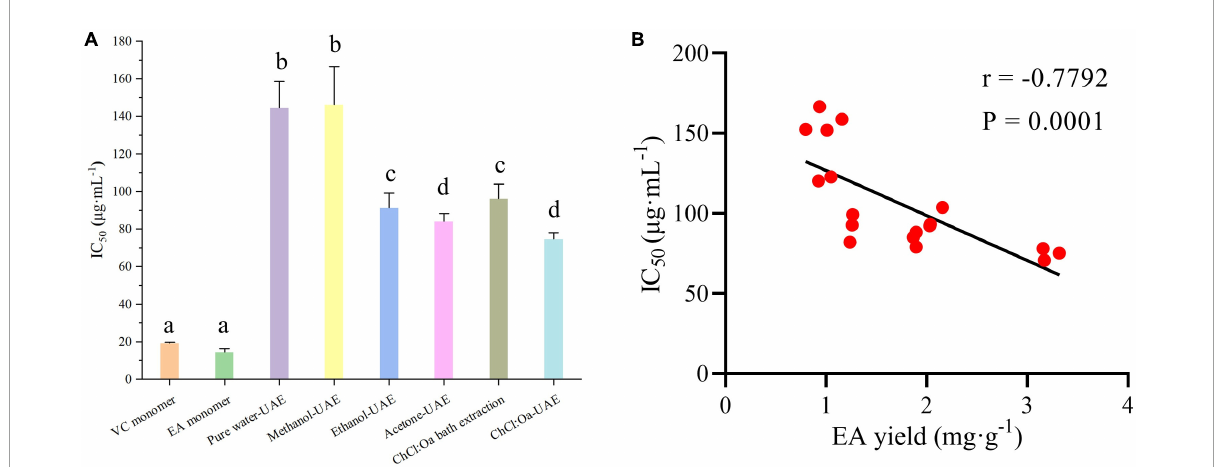
FIGURE5 1,1-diphenyl-2-picrylhydrazyl (DPPH) radical scavenging activity of vitamin C (VC) and ellagic acid (EA) monomers and pure water-ultrasound assisted extraction (UAE), methanol-UAE, ethanol-UAE, acetone-UAE, choline chloride-oxalic acid (ChCl:Oa) bath extraction, and choline chloride-oxalic acid-ultrasound assisted extraction (ChCl:Oa-UAE) extracts of Geum japonicum (GJ) (A) and Spearman rank correlation analysis between EA yield and IC 50 value (B) . (Different lowercase letters represent P < 0.05, otherwise P > 0.05, n = 3, correlation analysis n =